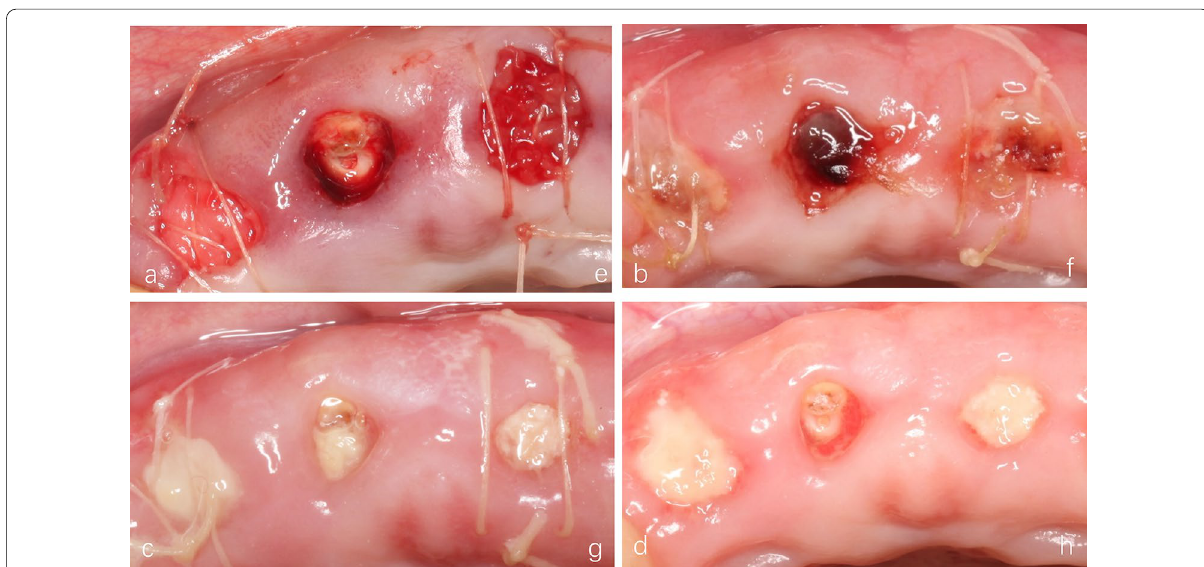
Fig. 5 Soft tissue healing at different times. a – d Images at 3, 7 and 14 days postoperation in Bio-Gide group. e , f Images at 3, 7 and 14 days postoperation in CGF group